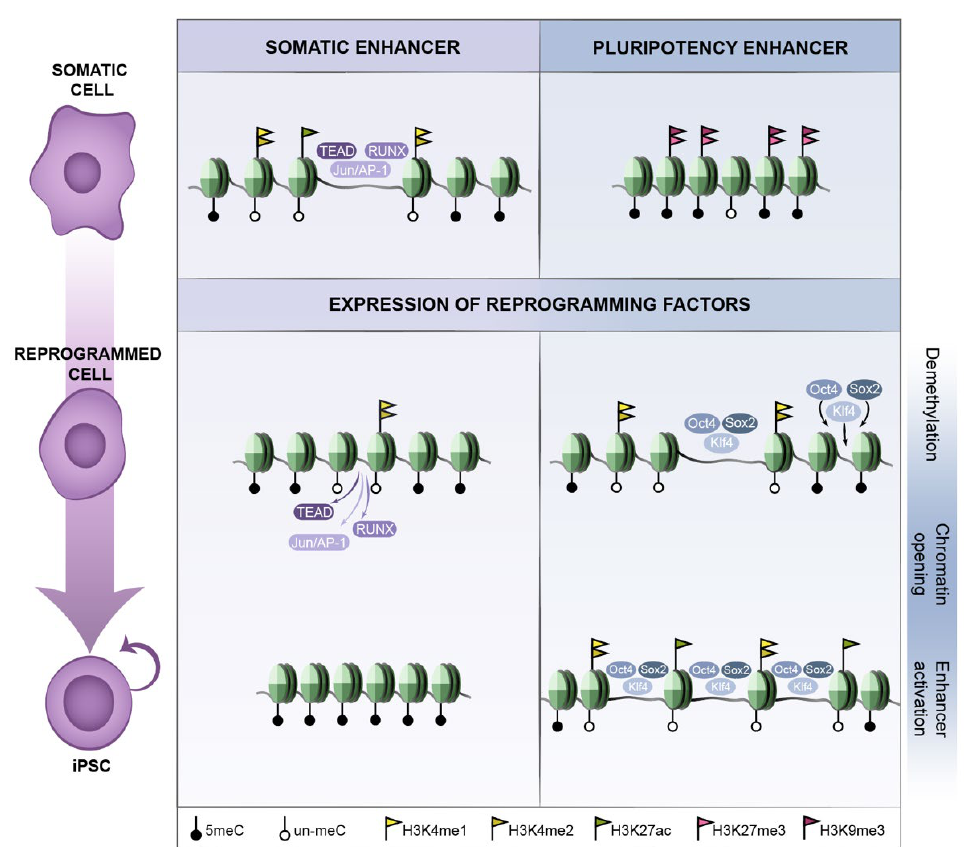
Figure 1. Remodelling of epigenetic enhancer features during reprogramming to pluripotency. Expression of reprogramming factors induces major epigenetic changes leading to repression of somatic enhancers and activation of the pluripotency regulatory landscape. The somatic enhancers ( left ), that in somatic cells are typically bound by active enhancer marks (i.e., H3K27ac, H3K4me1/2) and somatic TFs (e.g., TEAD, RUNX, Jun/AP-1), undergo epigenetic changes during the reprogramming process. This includes loss of active enhancer marks and eviction of somatic TFs, acquiring a closed methylated state in the resulting iPSCs. In contrast, pluripotent enhancers ( right ) are bound by repressive marks in somatic cells (i.e., H3K27me3, H3K9me3), and during the reprogramming process they gradually undergo demethylation, chromatin opening and eventually enhancer activa- tion. The pluripotent active enhancers are decorated by active enhancer marks and bound by the OSK reprogramming